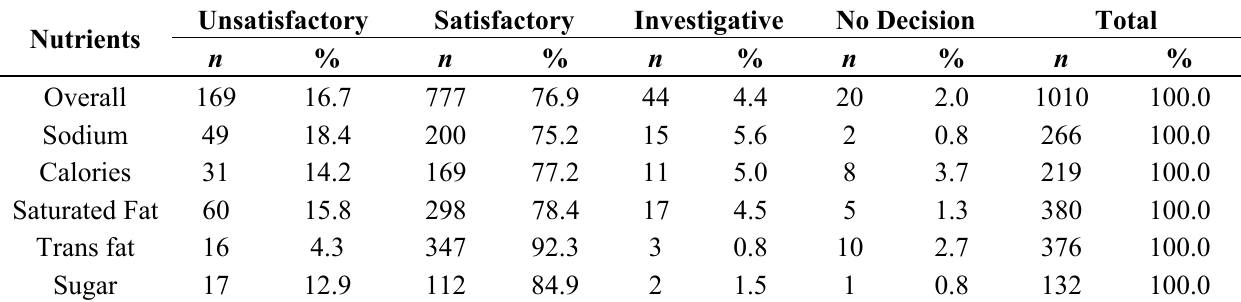
Table 2. Frequency of CFIA conclusions overall and for each